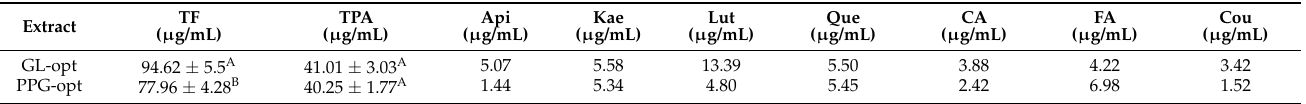
Table 6. Content of total flavonoids (TF), total phenolic acids (TPA), individual phenolic acids and flavonoid aglycones in M. lupulina